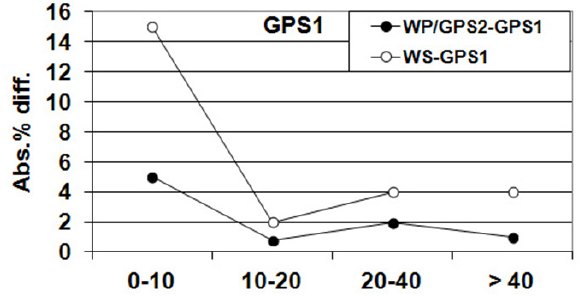
Fig. 8. Absolute median percentage difference between W P/ GPS2 (black dots) and W S (white dots) versus W GPS1